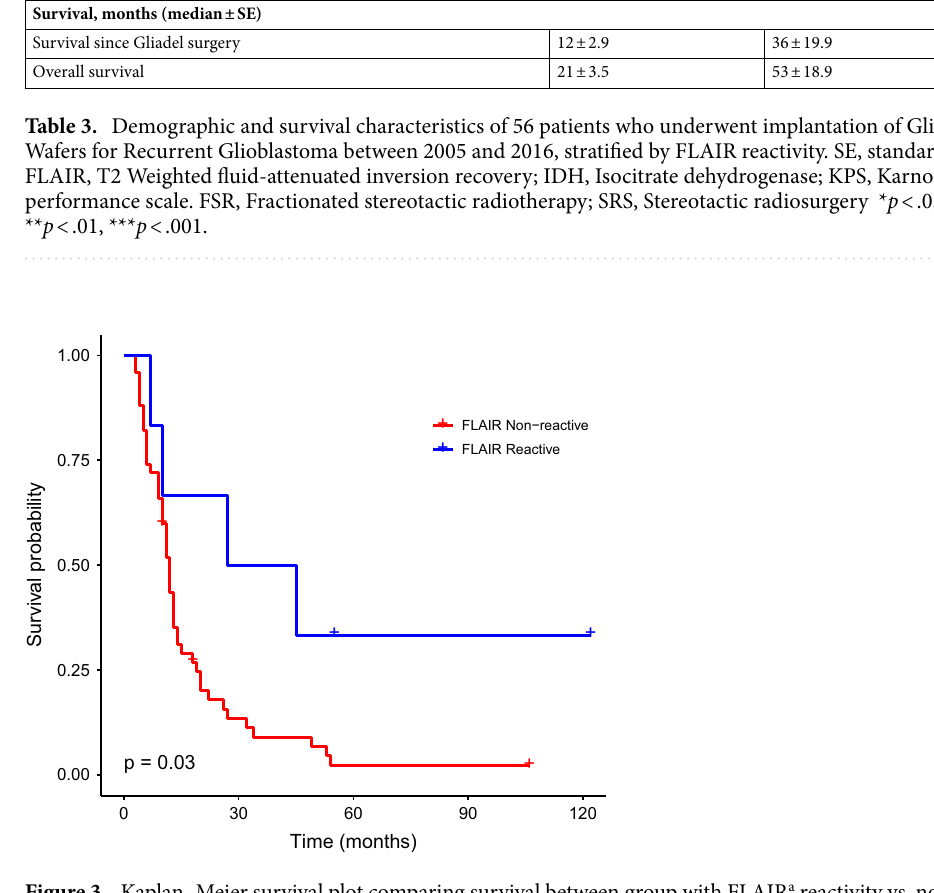
Figure 3. Kaplan–Meier survival plot comparing survival between group with FLAIR a reactivity vs. non- reactivity. a T2-Weighted fluid-attenuated inversion